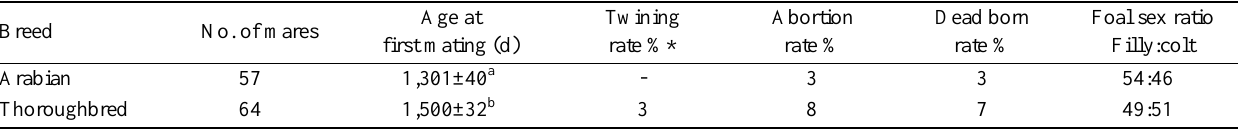
Values in the same column with different superscripts are different (p<0.05). * Termination in abortion.